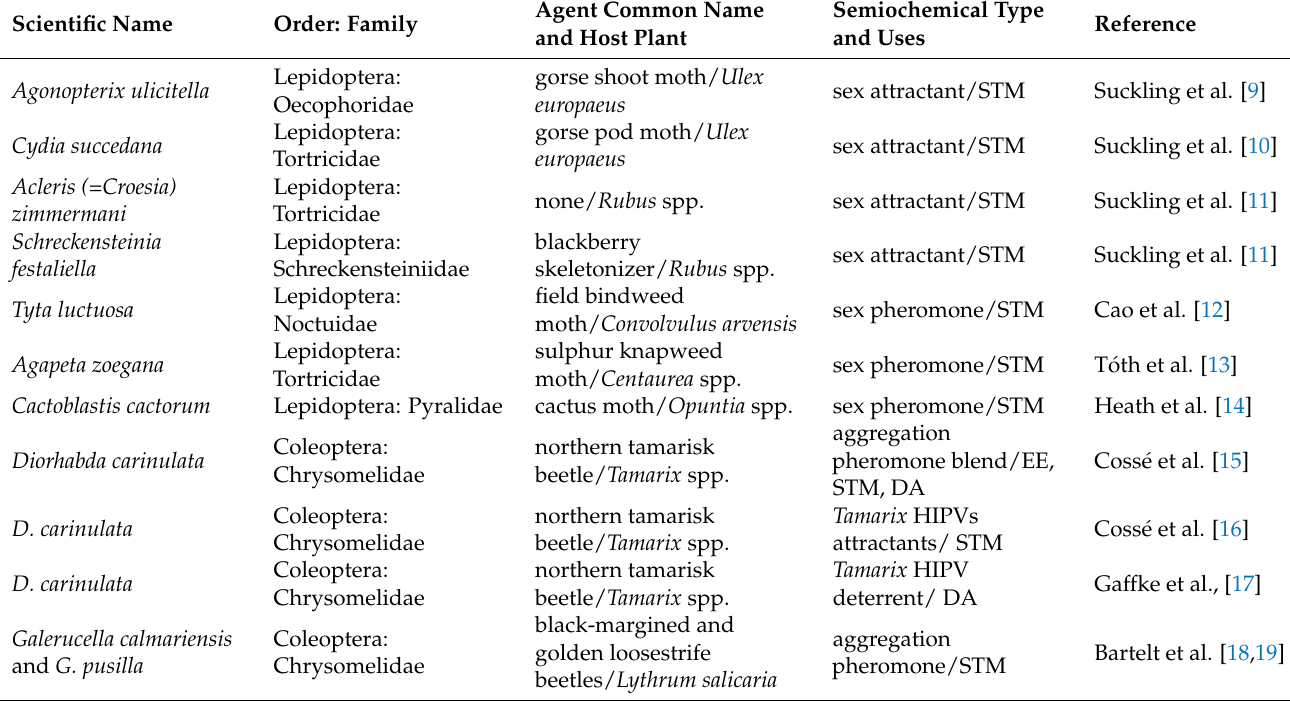
Table 1. Weed biological control agents with identified semiochemicals. Three uses for identified semiochemicals are en- hancing agent establishment (EE), sentinel trapping and monitoring (STM) and directing activity (DA). These categories are described in detail in the section on enhancing weed biocontrol. Herbivore-induced plant volatiles are abbreviated